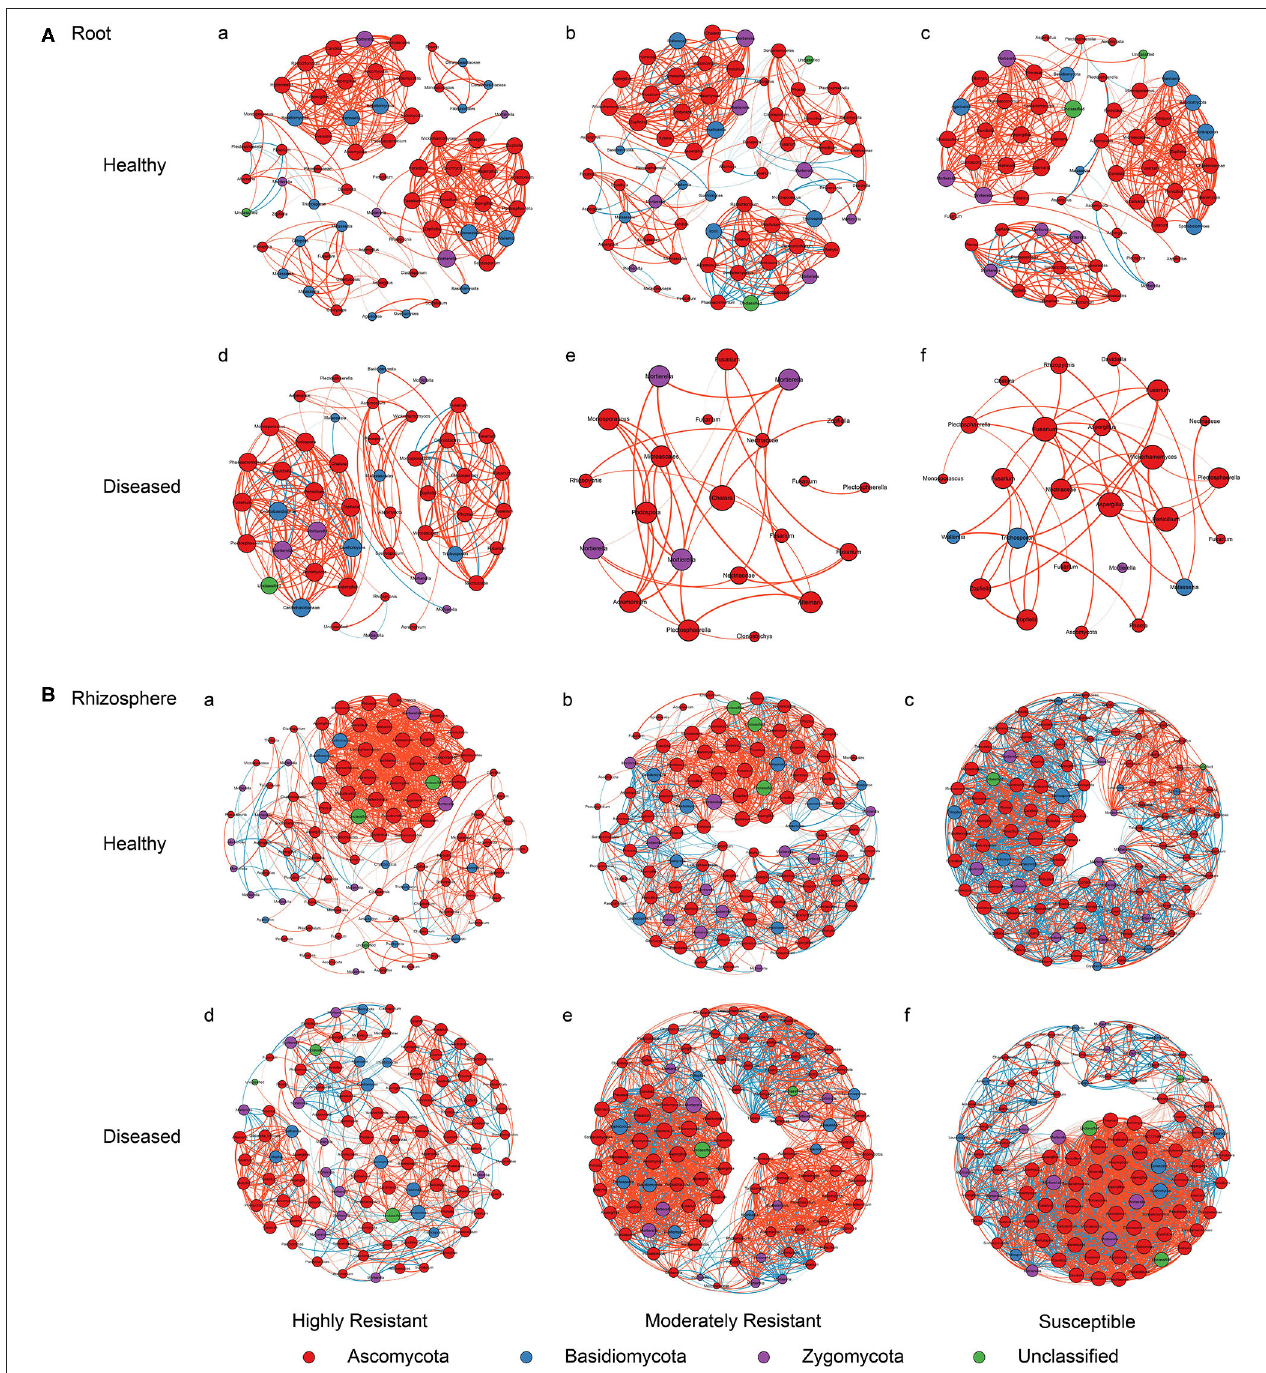
FIGURE 6 | Network co-occurrence analysis of fungal communities in roots and rhizosphere soil. A connection represents a Pearson correlation with a magnitude > 0.7 (red edges: positive correlation) or < − 0.7 (blue edges: negative correlation) which is statistically significant ( P < 0.05). Each node represents taxa at OTU level. The size of each node is proportional to the number of connections, which is based on ranking of degree with min size = 20 and max size = 50.